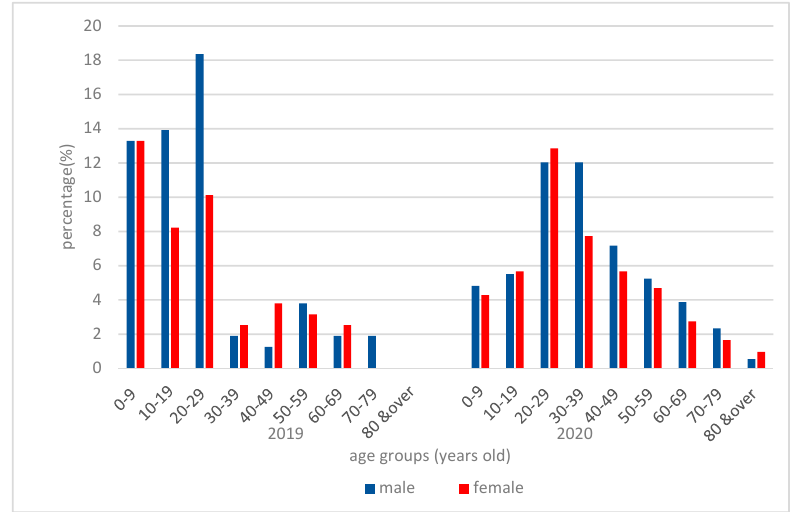
Figure 2. Comparison of patients’ age and gender distribution at the emergency room at the